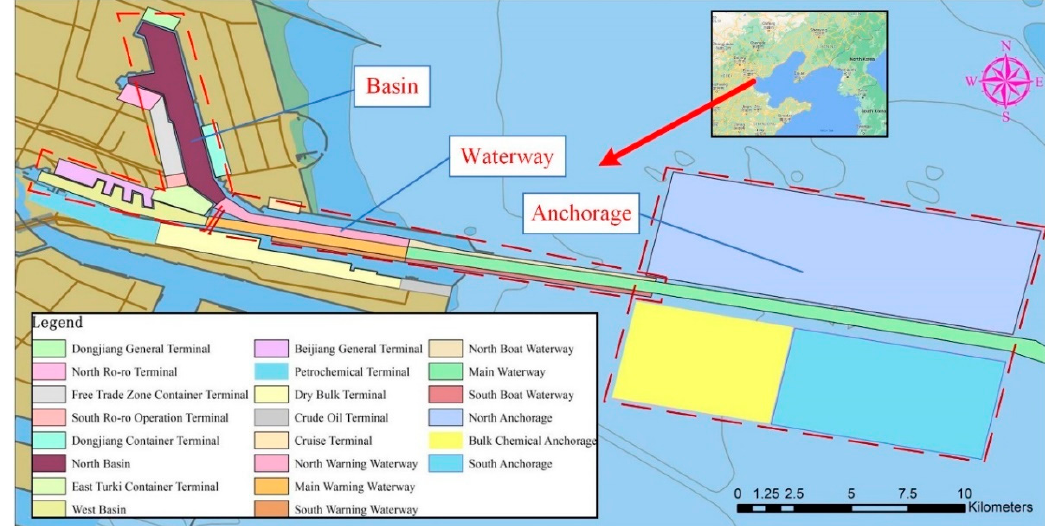
Figure 6. Layout of water and land facilities in Tianjin Port.